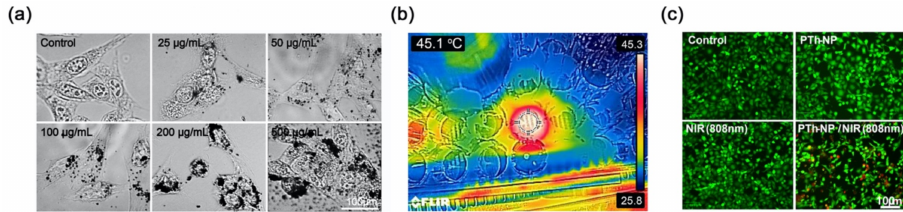
Figure 5. In vitro cellular uptake and photothermal e ff ects of PTh–NPs. ( a ) Cellular uptake image of PTh–NPs in CT-26 cells using microscopy after 3 h of incubation. ( b ) Infrared photothermal image of PTh–NPs (100 µ g / mL) dispersed in CT-26 cells culture media under 808 nm laser irradiation after 5 min at 2.0 W / cm 2 . ( c ) Live / dead fluorescence images of PTh–NPs treated CT-26 cells with / without 808 nm laser irradiation (2.0 W / cm 2 , 5